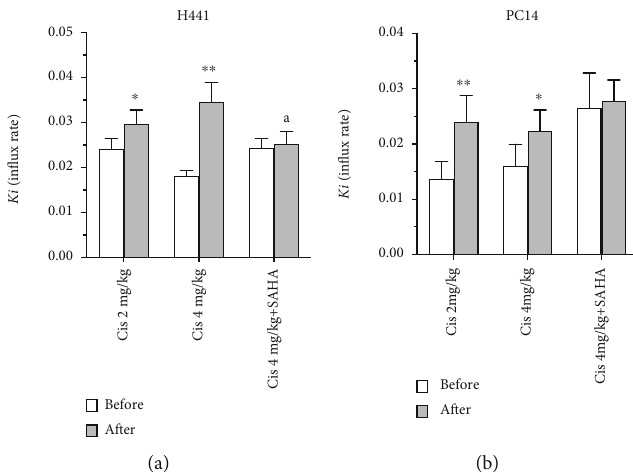
Figure 2: Comparison of tumor [ 18 F]FAHA Ki values, based on graphical analyses before and after drug administration. [ 18 F]FAHA Ki values signi fi cantly increased in the H441 and PC14 xenografts after administration of cisplatin in Groups A (2 mg/kg cisplatin) and B (4 mg/kg cisplatin), but not in Group C (4 mg/kg cisplatin +300mg/kg SAHA). Data are mean ± SEM . Di ff erent superscript letters indicate signi fi cant di ff erences ( ∗ p < 0 : 05 , ∗∗ p < 0 : 005 compared to the Ki values before drug administration; a p < 0 : 05 , Group C vs. Group